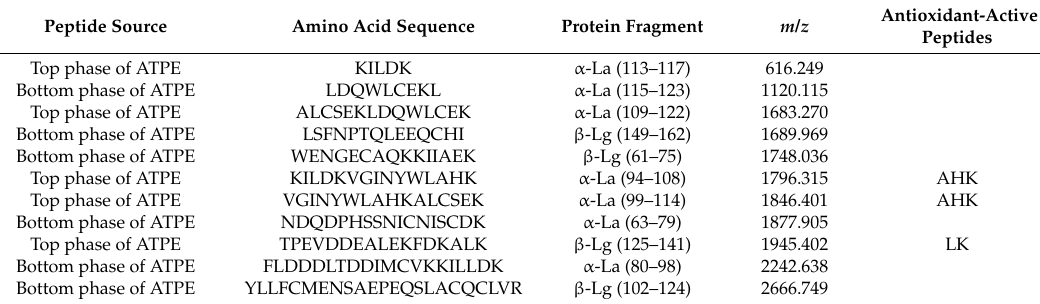
Table 2. Amino acid sequence of peptides of different phases in ATPE.